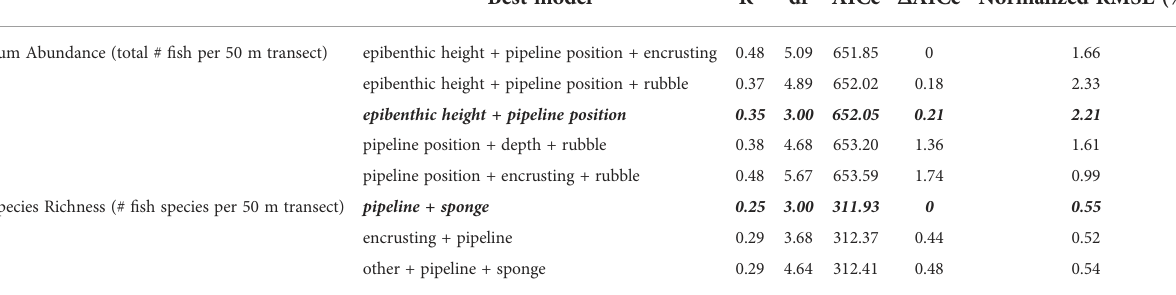
TABLE 3 Top Generalized Additive Models (GAM) for explaining relationships between fi sh abundance (total # fi sh/50 m) and fi sh species richness (# species/50 m), with explanatory variables relating to pipeline characteristics and benthic community composition (epibenthic height, pipeline position, depth, % cover of: dead shells, encrusting, other, rubble, sand,